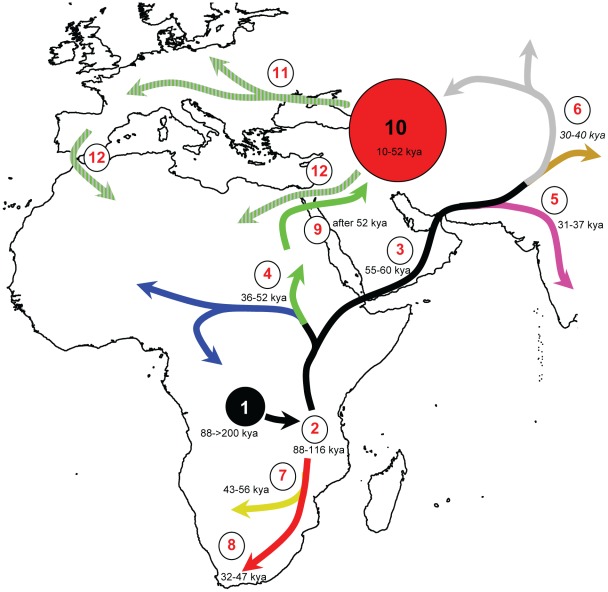
Chronological reconstruction of the major population events occurring during the intimate human-H. pylori association.Black lines indicate undifferentiated populations and all other lines are color-coded according to population as in Figs. 1, 3A, 4A, 6A. The sequence of events is as follows: 1) Initial acquisition of H. pylori by a human ancestor; 2) Divergence of H. pylori into two super-lineages; 3) First successful migration of modern humans Out of Africa [7], [42] via the southern route [57]; 4) H. pylori divergence into hpAfrica1 and hpNEAfrica with migration eastwards (hpNEAfrica) and westwards (hpAfrica1); 5) Divergence of H. pylori out of Africa into hpSahul [8] and 6) hpAsia2 and hpEastAsia; 7) Host jump from San to large felines giving rise to H. acinonychis. 8) Southward migration of San [16] carrying the ancestor of hpAfrica2; 9) Second successful migration Out of Africa via the Levant; 10) Hybridization of AE1 from central and south-west Asia and AE2 from north-east Africa [7] in the Middle East or western Asia resulting in hpEurope; 11) Spread of hpEurope bacteria to Europe; 12) Back migration from the Middle East [75], [76] and Spain [74] spreading hpEurope into North Africa. Dates in italics represent estimates obtained from sources other than H. pylori.